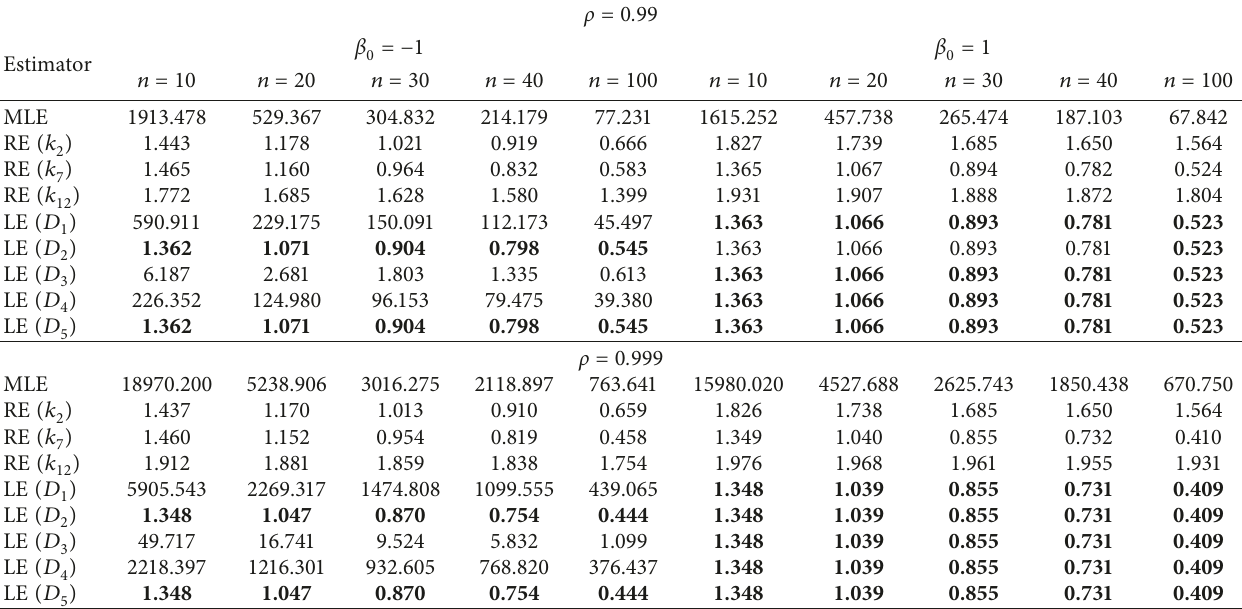
Table 9: Estimated SMSE values for different n, ρ ,k, d, and β